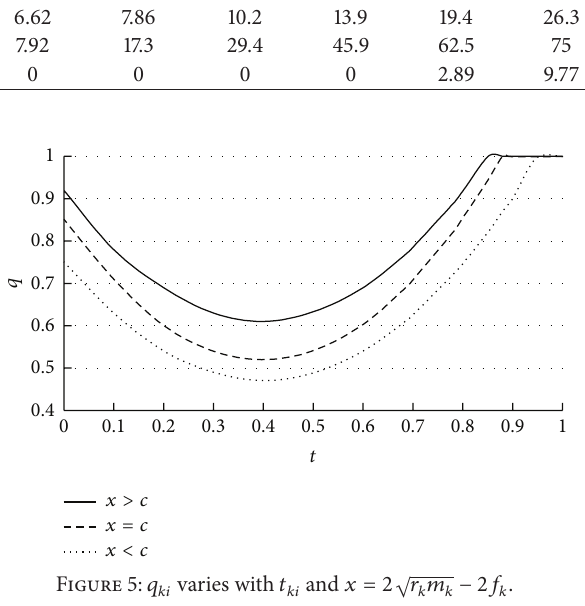
Figure 5: 𝑞 𝑘𝑖 varies with 𝑡 𝑘𝑖 and 𝑥 = 2√𝑟 𝑘 𝑚 𝑘 − 2𝑓 𝑘 .